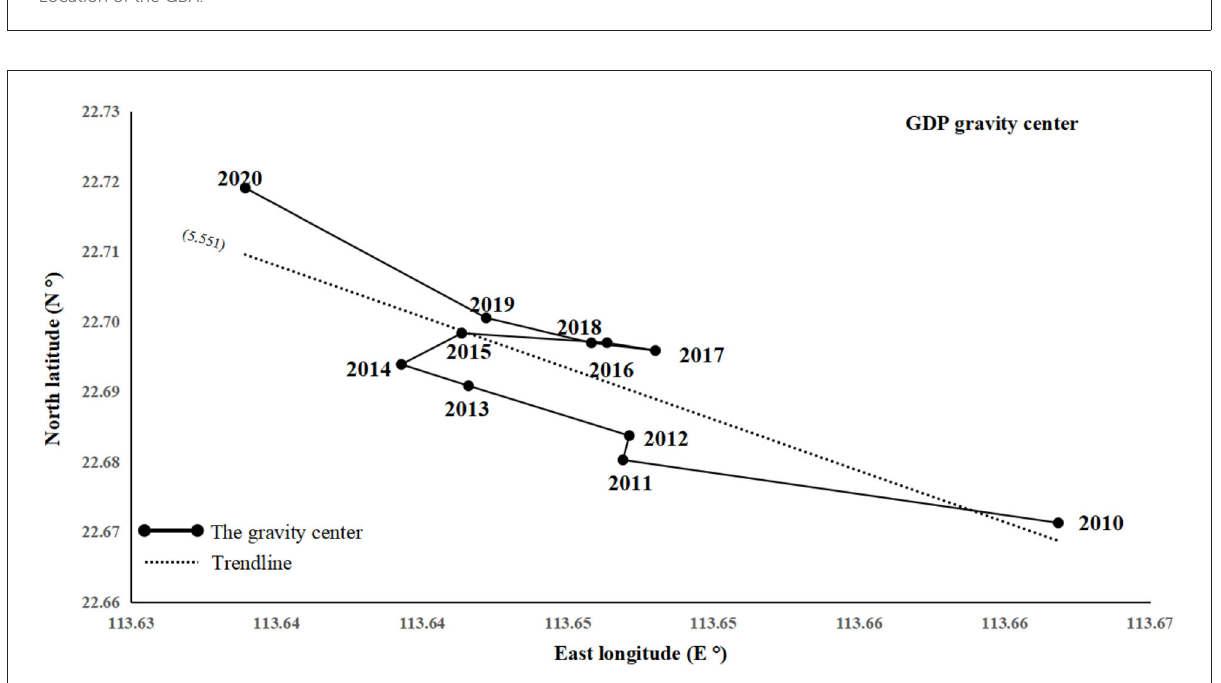
FIGURE3 Movement in the economic gravity center of the